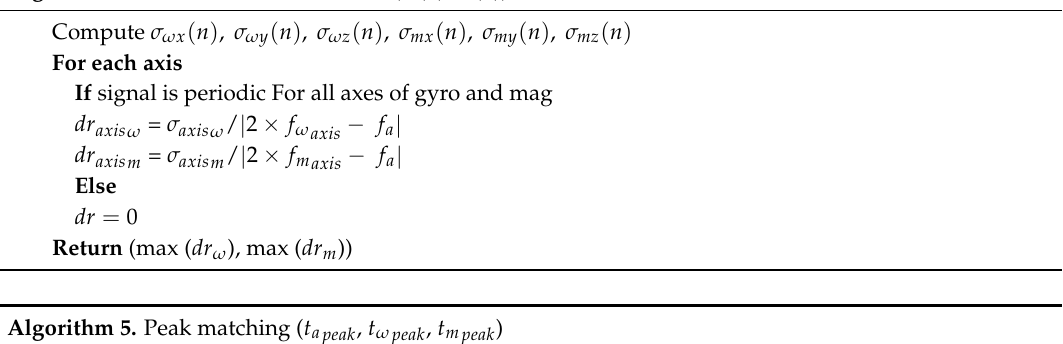
Algorithm 5. Peak matching ( t apeak , t ω peak , t mpeak )